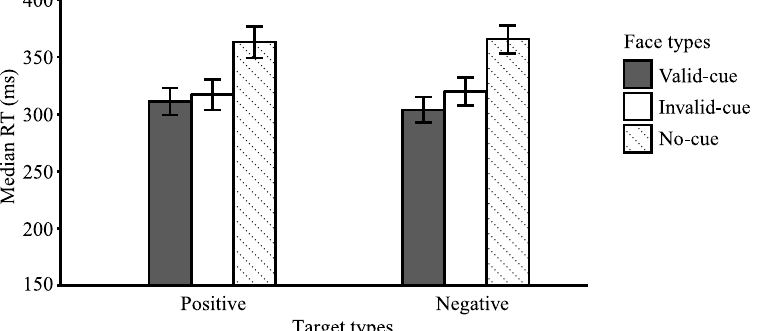
Fig 3. Means of median response times for each type of gaze and emotional valence in Experiment 1. Error bars represent the standard error of the mean ( SEM ).